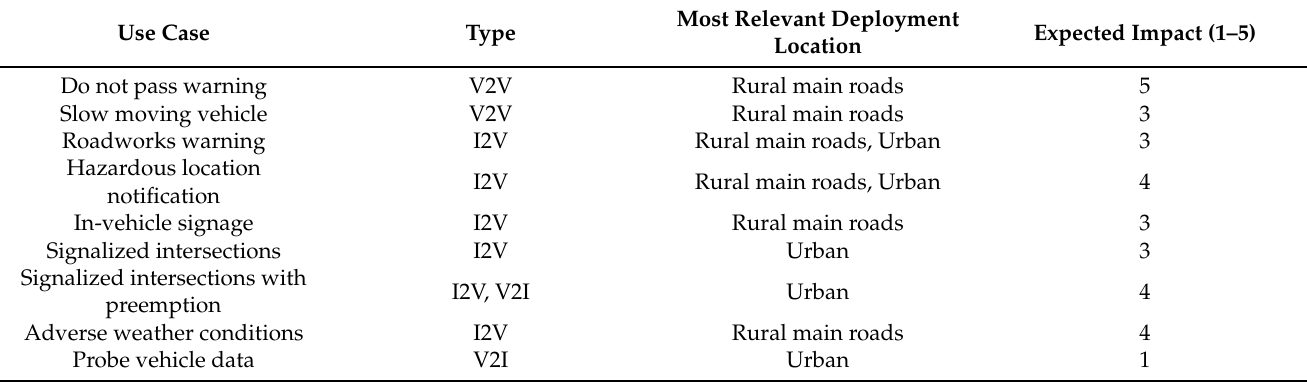
Table 1. Sample V2X use